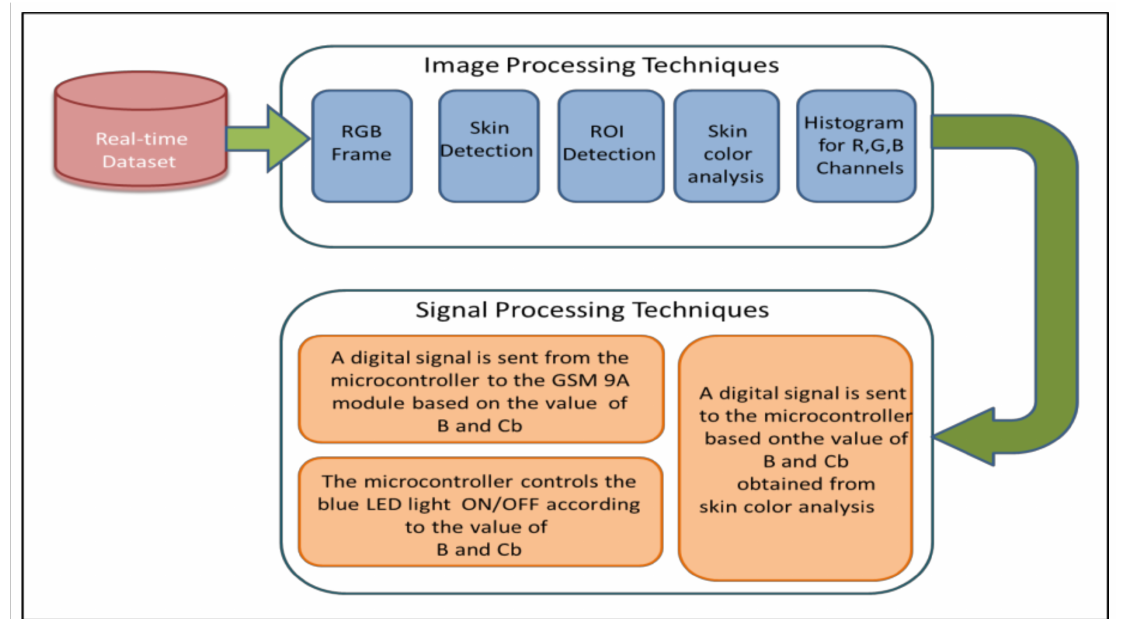
Figure 3. The general design of the proposed